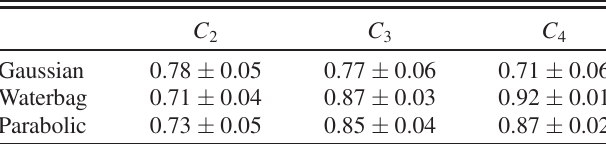
where we have again assumed η x ¼ η y ð ≡ η Þ for simplicity. Equation (15) agrees with Eq. (14) for positive k and l